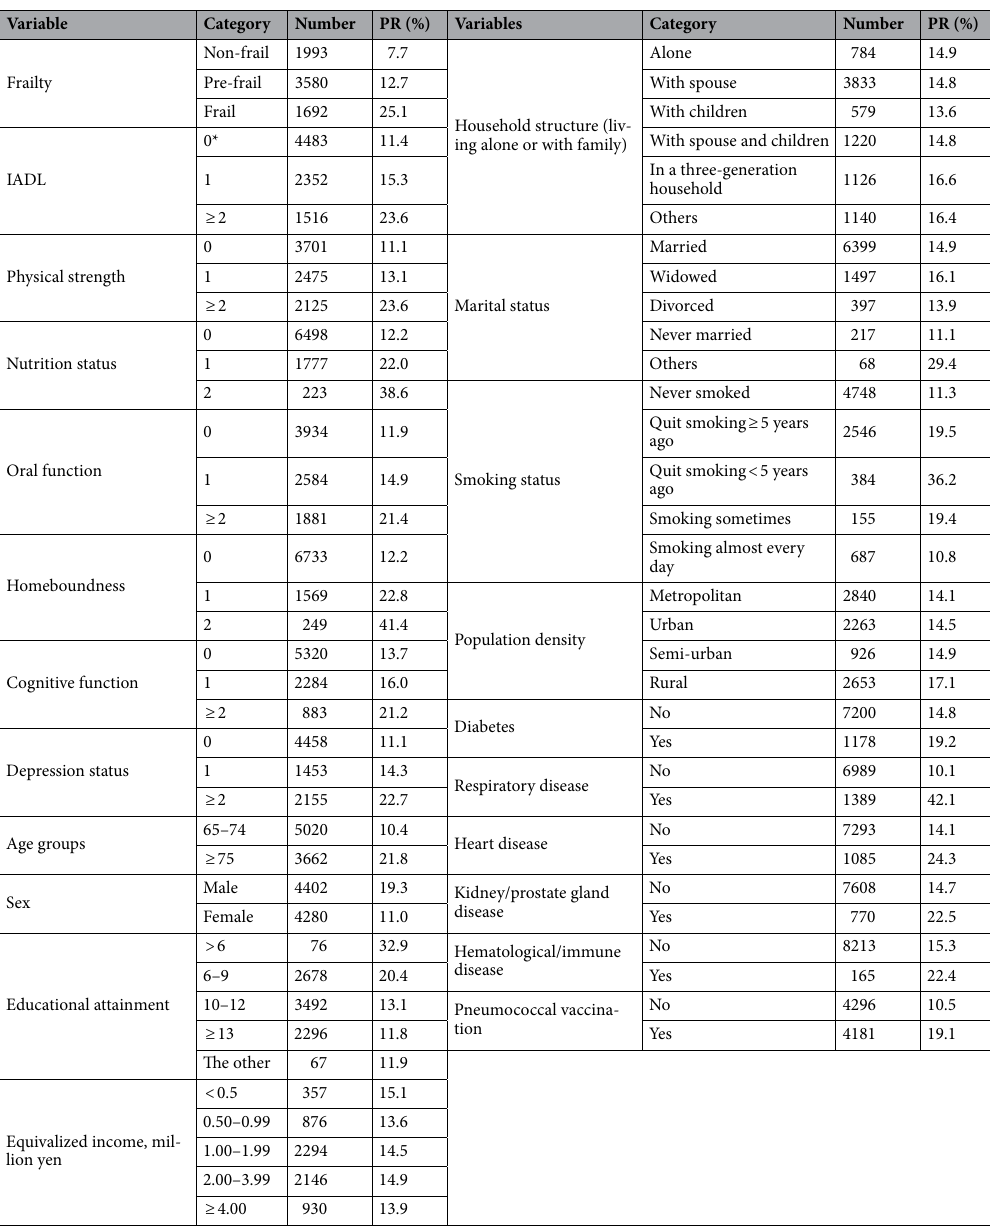
Table 2. Prevalence rates of hospitalization due to pneumonia in comparison with the characteristics of older adults. *Numbers in IADL, physical strength, nutrition status, oral function, homebound, cognitive function, depressive mode are the numbers of the applicable KCL questions for the older adults. PR prevalence rate, IADL instrumental activity of daily living, KCL Kihon